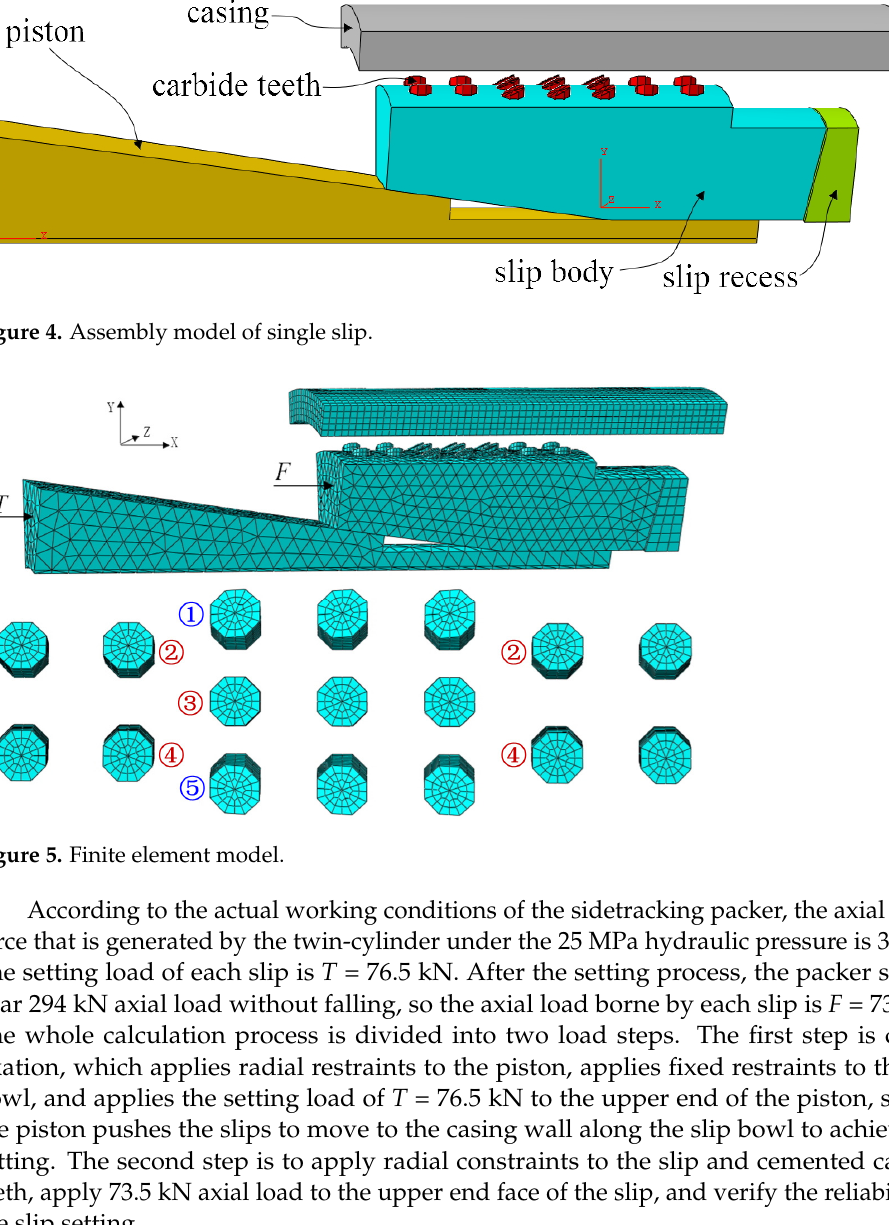
Figure 5. Finite element model.